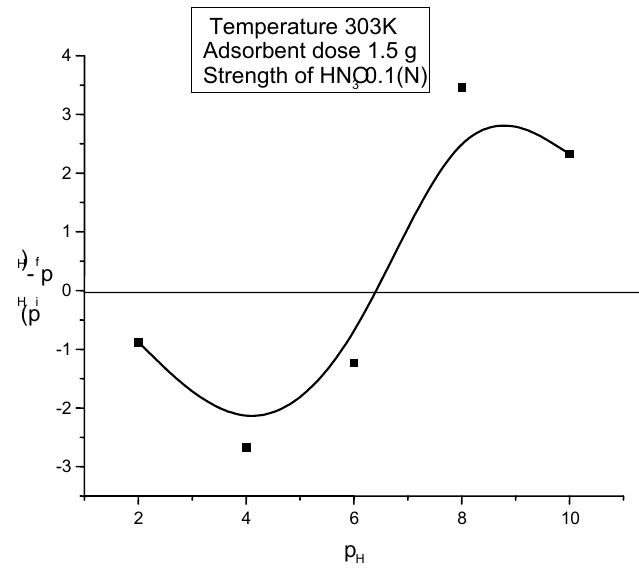
Figure 1. Zero Point charge of eggshell